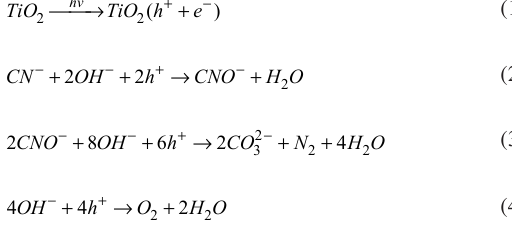
films with different 2 values estimated g